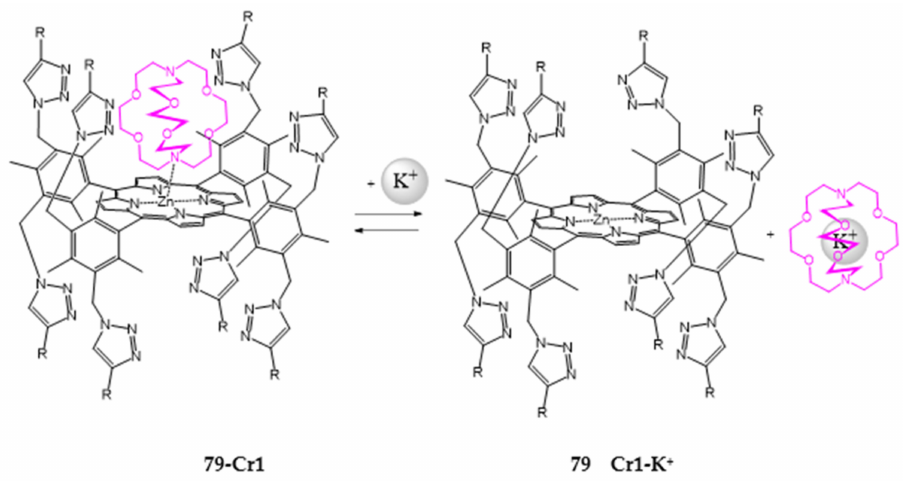
Scheme 29. Complexation of the receptor 79 with Cr1 in the presence of K + .